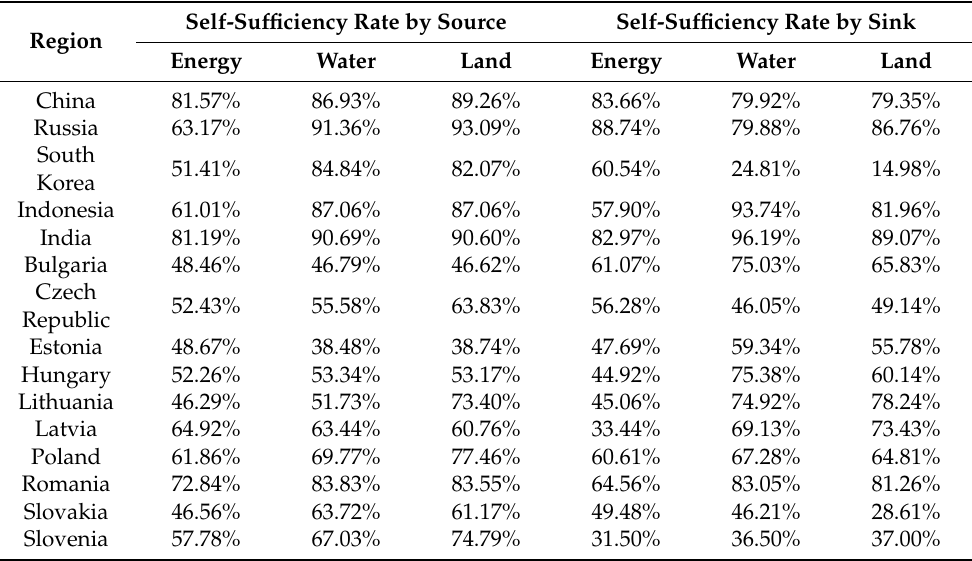
Table 2. Self-sufficiency rate of selected countries along the BRI route by source and sink.